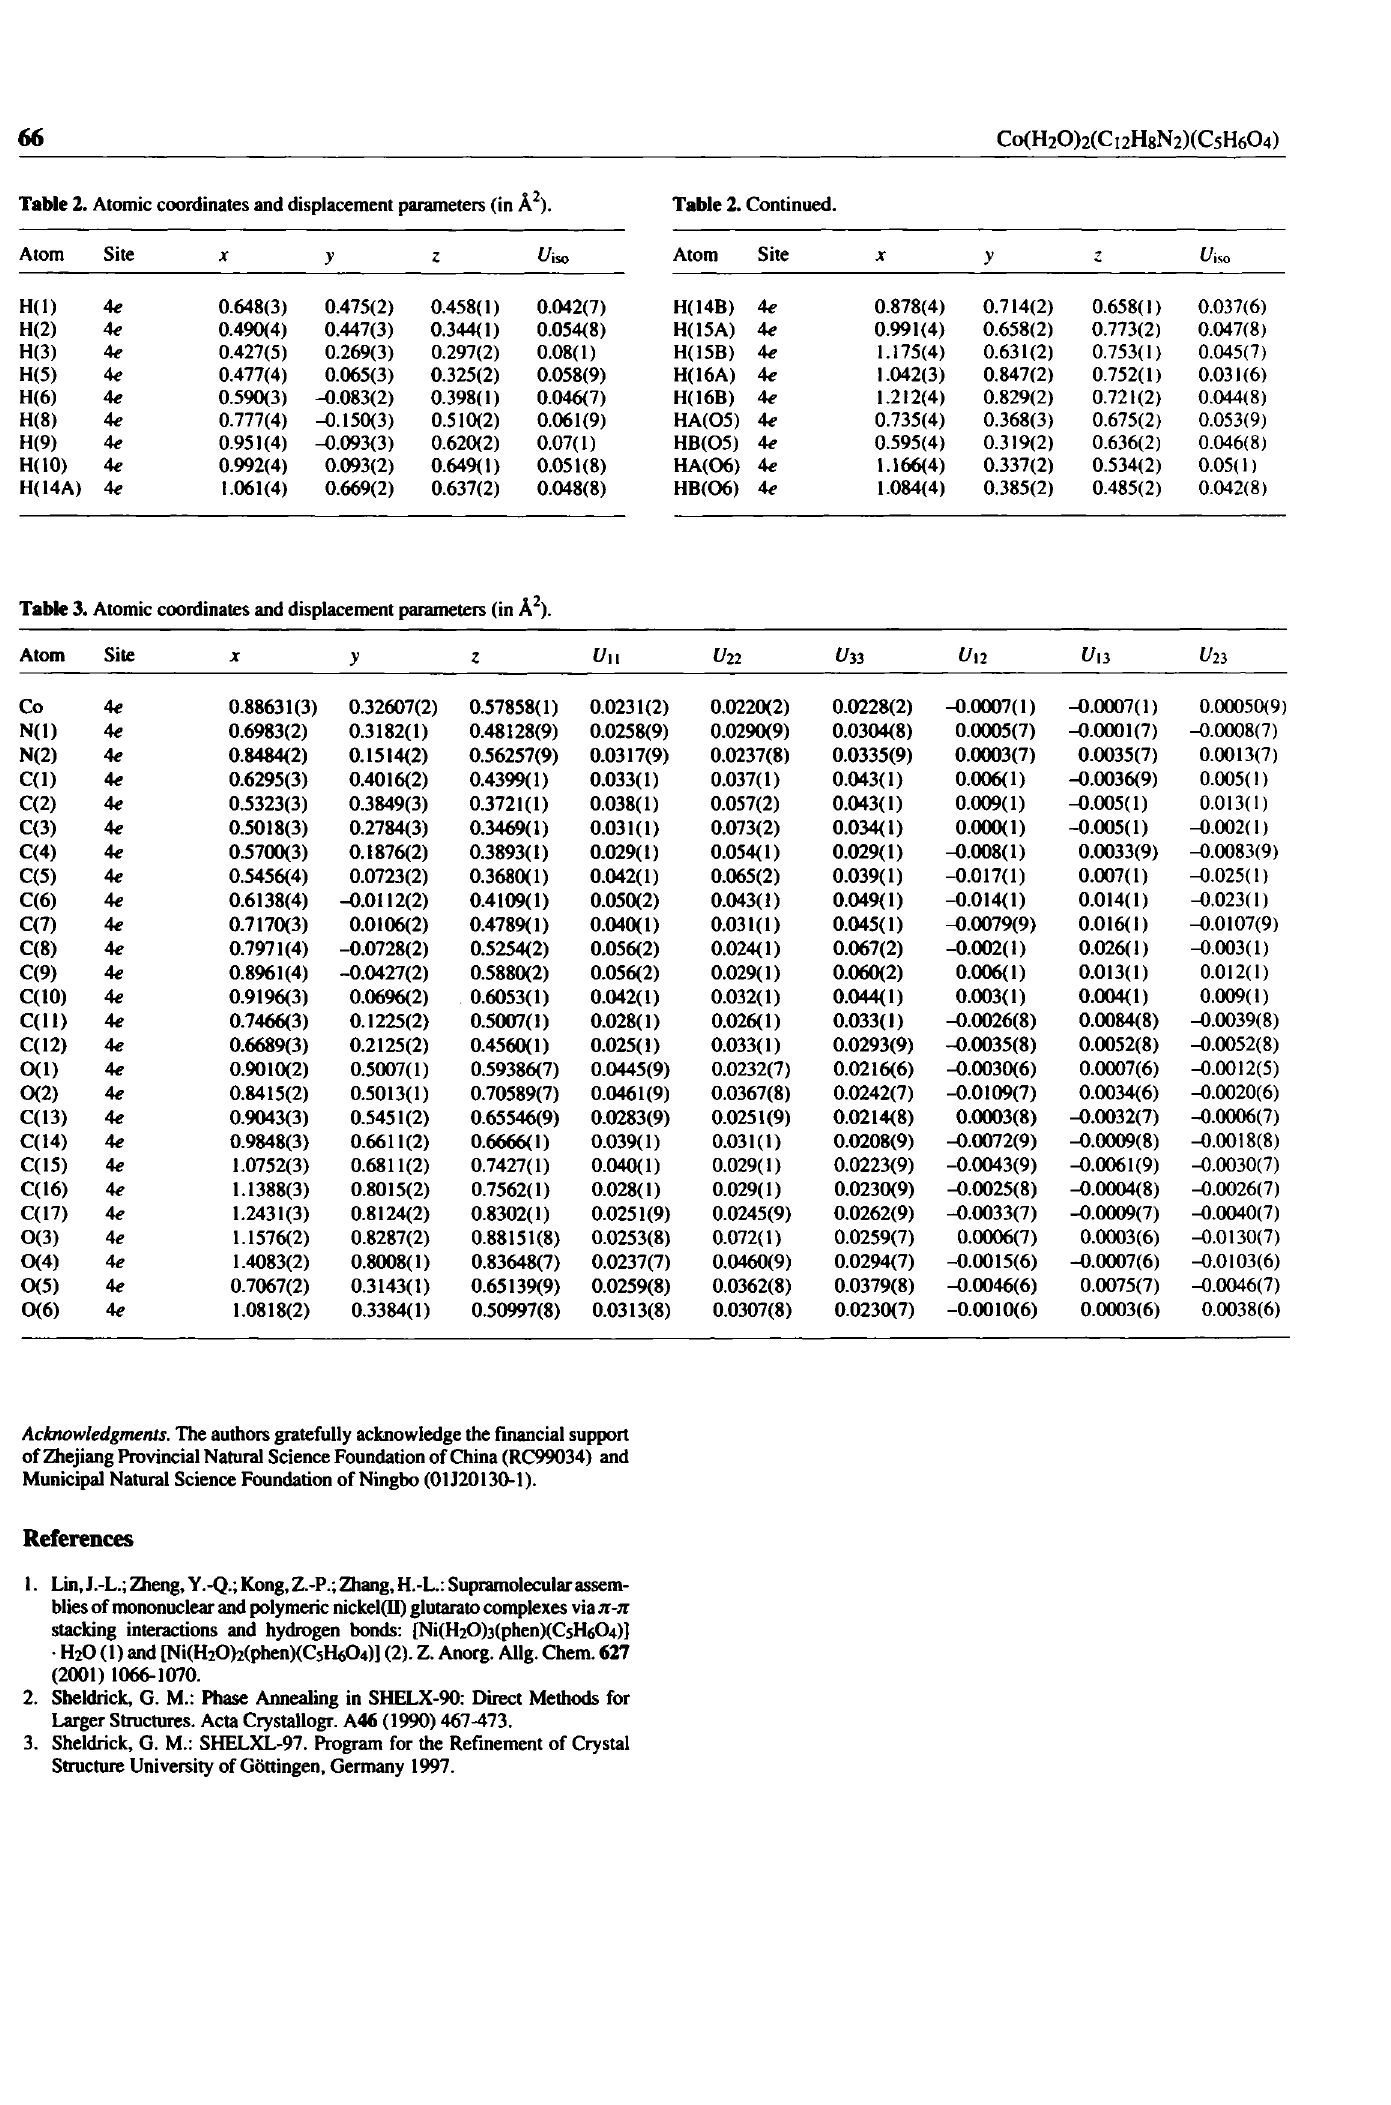
Table 3. Atomic coordinates and displacement parameters (in Â 2